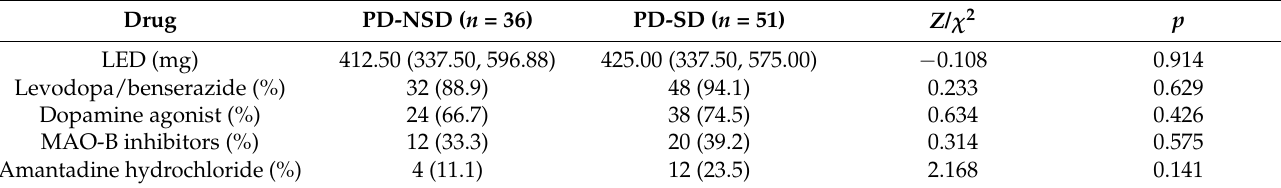
Table 2. Antiparkinsonian medications between PD